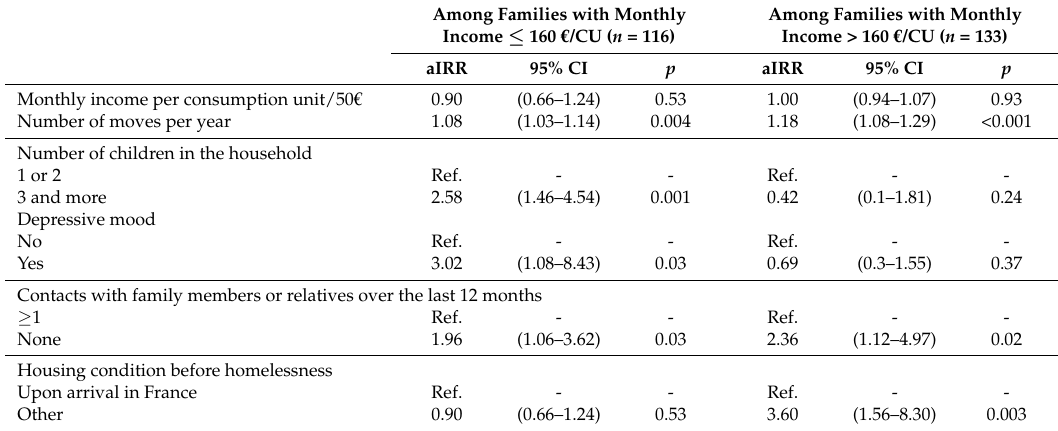
Table 4. Model 2: factors associated with very low food security (stratified multivariate